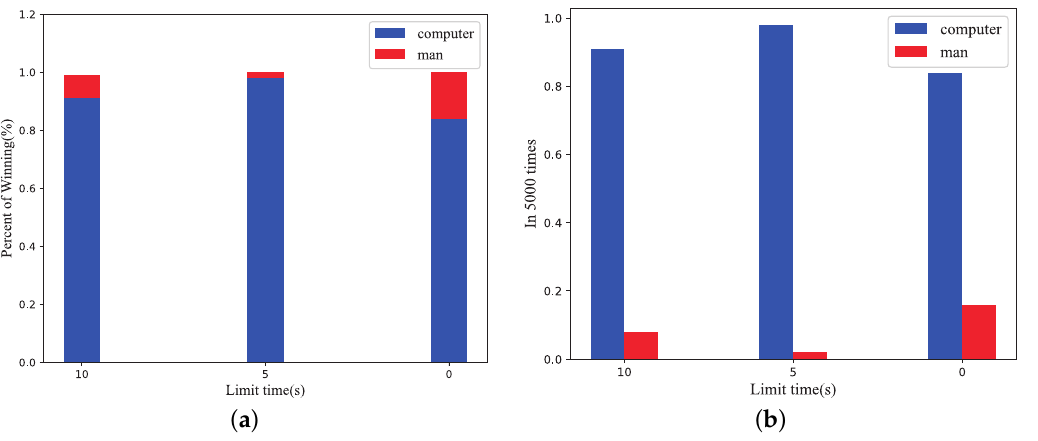
Figure 4. Contrast in match results between humans and machine: ( a ) statistics on the match results; ( b ) comparison of wins.